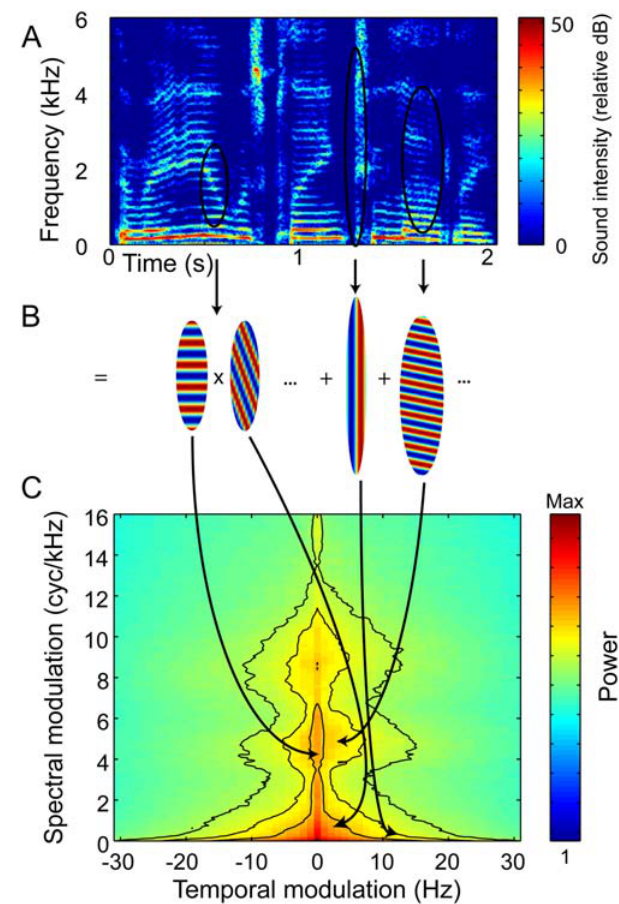
Figure 1. Component spectrotemporal modulations make up the modulation spectrum. (A) Spectrogram of a control condition sentence, ‘‘The radio was playing too loudly,’’ reveals the acoustic complexity of speech (Audio S1). All supporting sound files have been compressed as .mp3 files for the purpose of publication; original .wav files were used as stimuli. (B) Example spectrotemporal modulation patterns circled in the sentence (A) can be described as a time-varying weighted sum of component modulations. (C) The MPS shows the spectral and temporal modulation power in 100 sentences. The outer, middle, and inner black contour lines delineate the modulations contained in 95%, 90%, and 85% of the modulation power, respectively. Down-sweeps in frequency appear in the right quadrant, whereas upward drifts in frequency are in the left quadrant. Slower temporal changes lie near zero on the axis, while faster changes result in higher temporal modulations towards the left and right of the graph.